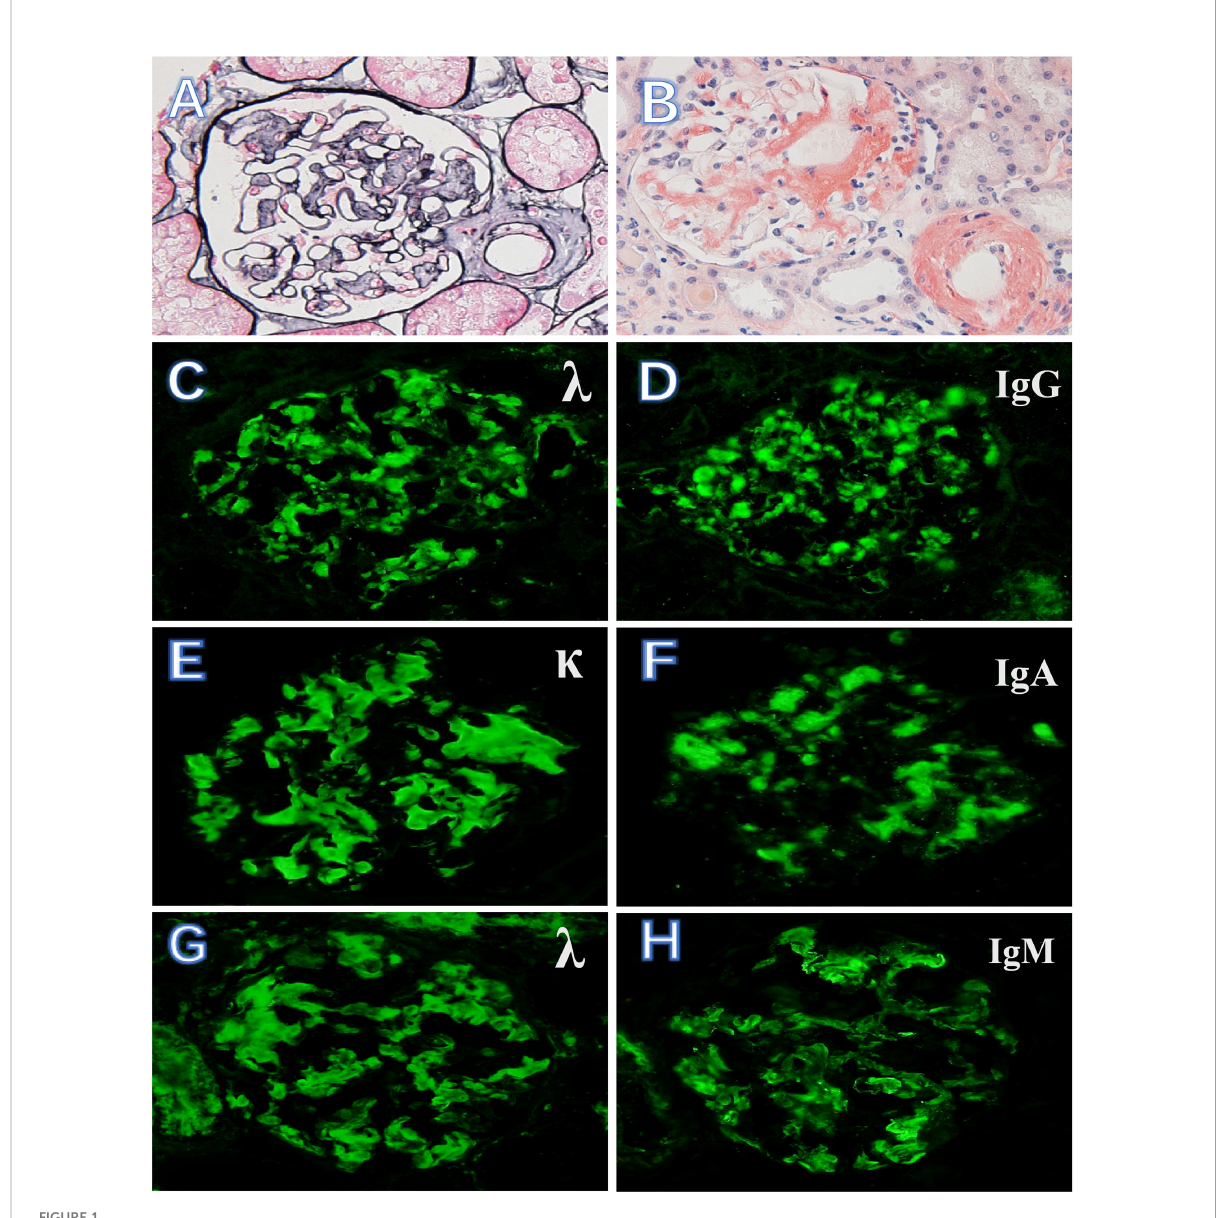
FIGURE 1 Kidney biopsy fi ndings in AL amyloidosis with immune complex deposition. (A, B) Massive amyloid deposits are present in glomeruli and arterioles (PASM, ×400) and as brick-red in Congo red stain (×400). (C, D) AL amyloidosis with l light chain-restricted staining and Ig G++. (E, F) k light chain-restricted staining and Ig A++. (G, H) l light chain-restricted staining and Ig M++ (immuno fl uorescence,